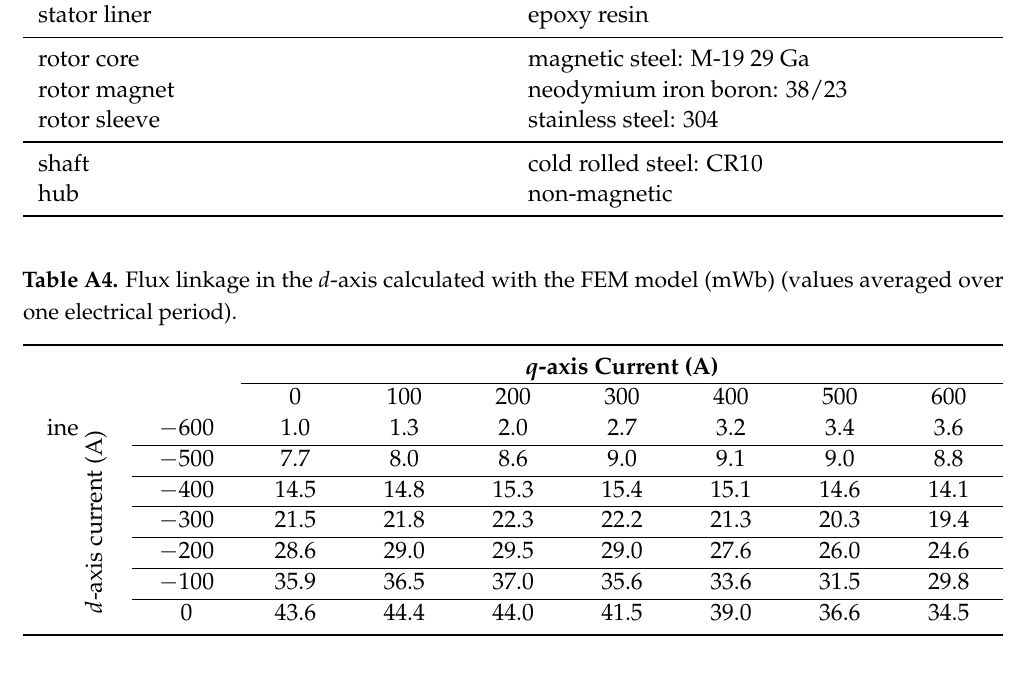
Table A5. Flux linkage in the q -axis calculated with the FEM model (mWb) (values averaged over one electrical period).